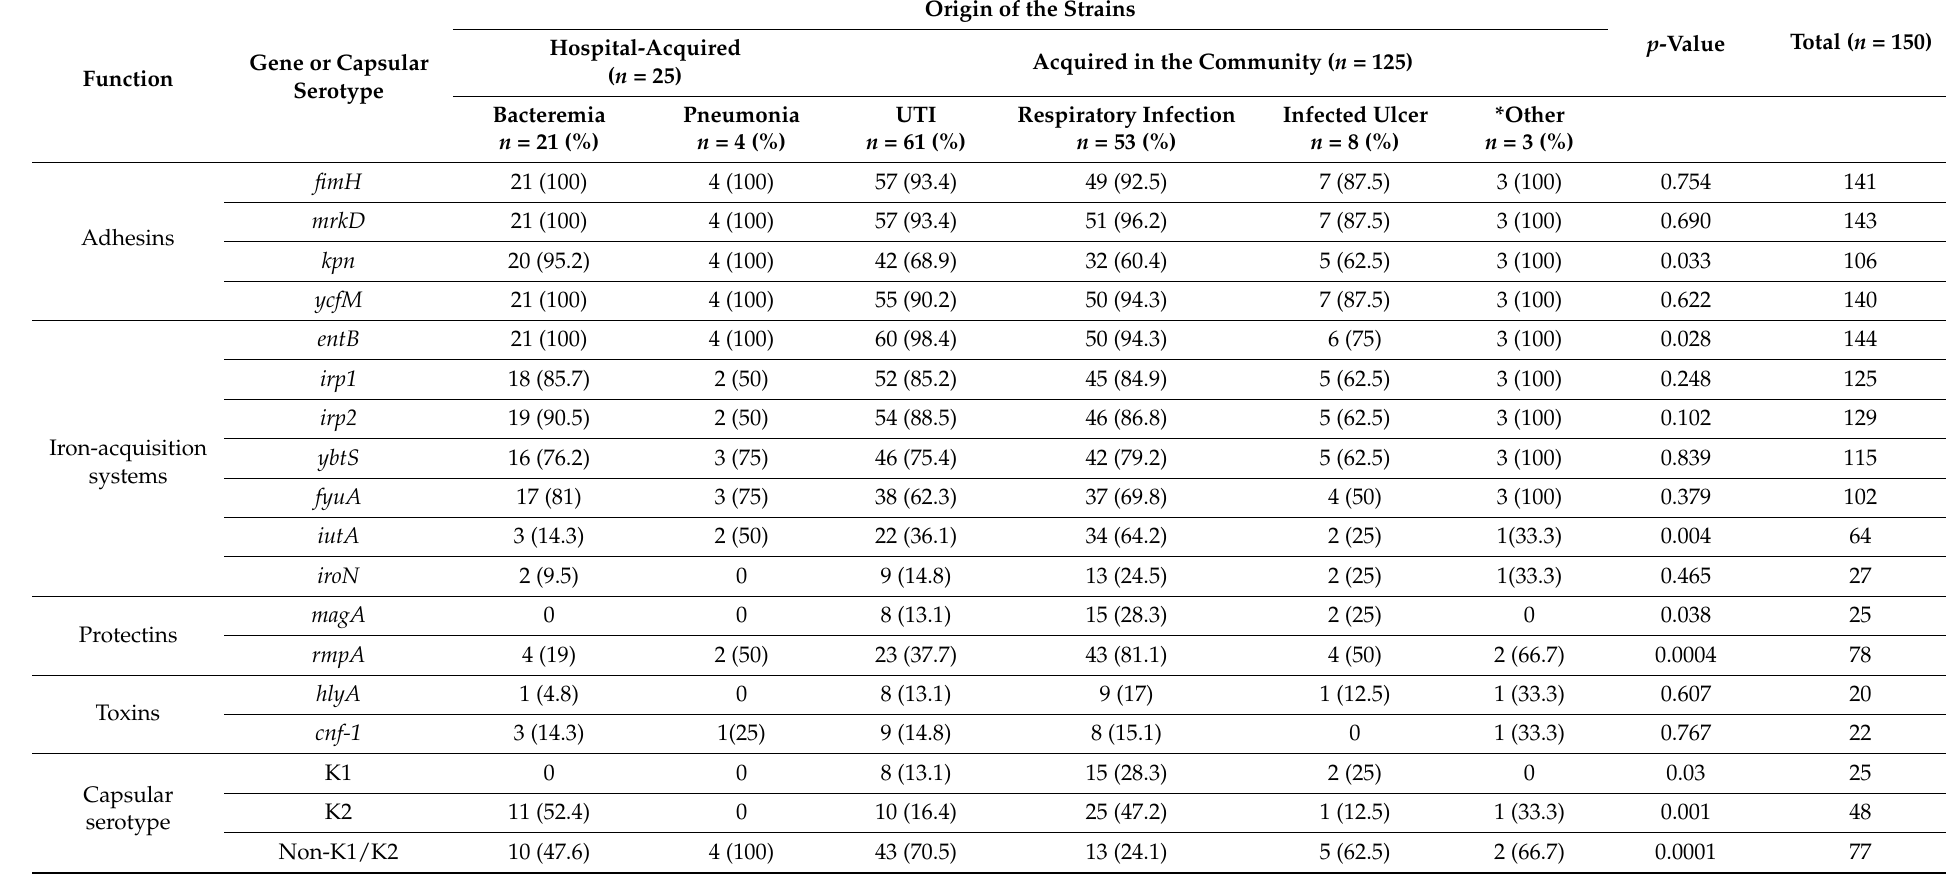
Origin of the Strains